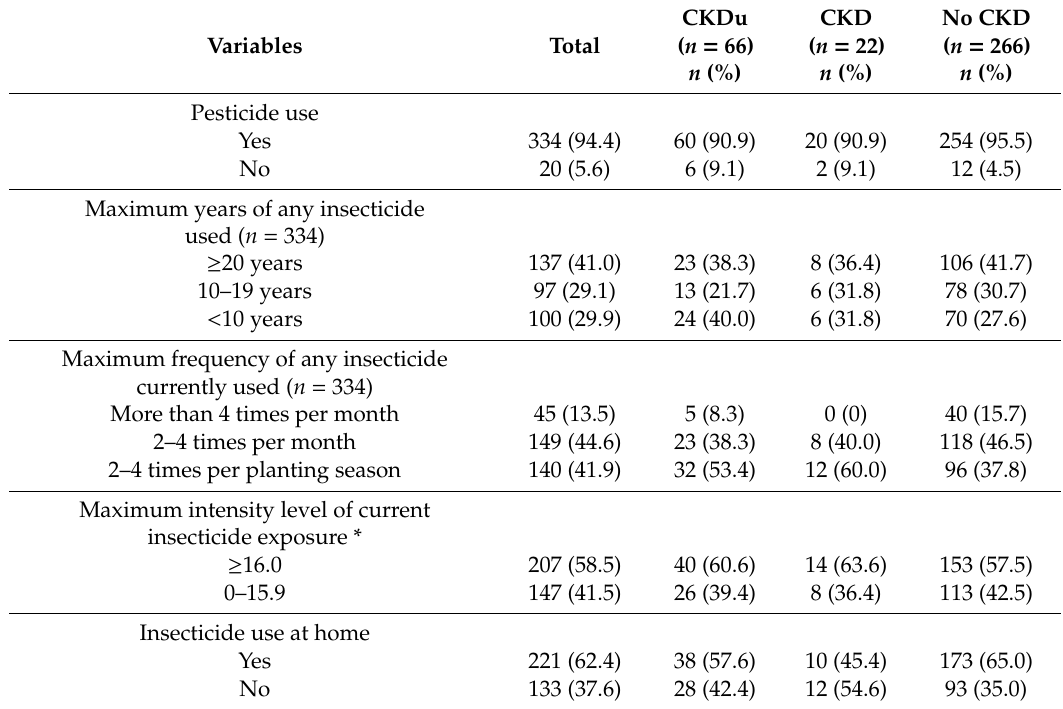
Table 4. Pesticide use and CKD / CKDu among male farmers in study location in West Java.